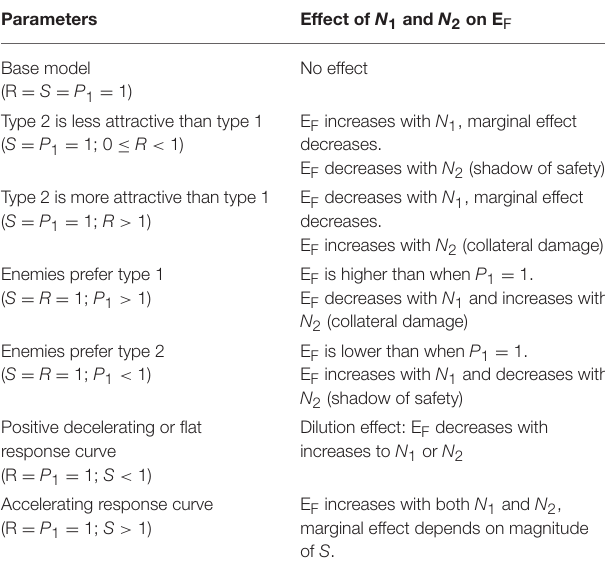
TABLE 2 | Summary of major predictions of the model.